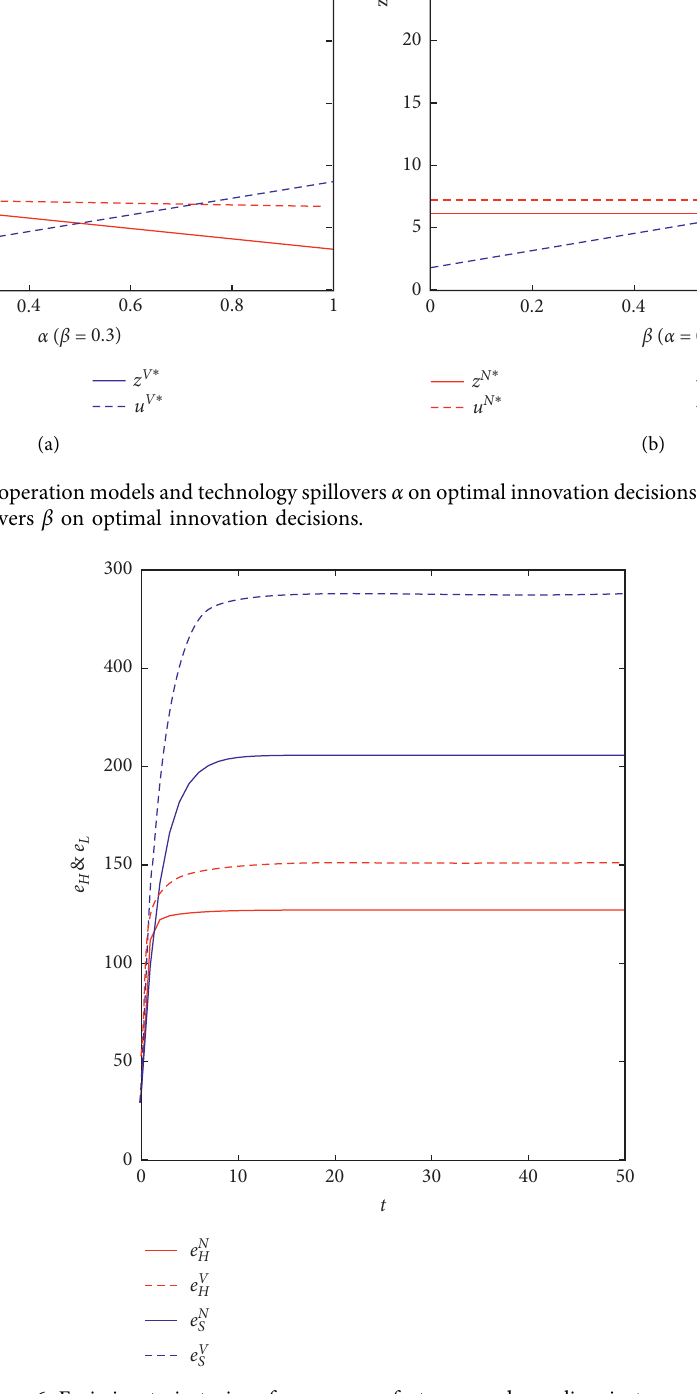
Figure 6: Emission trajectories of green manufacturers and suppliers in two